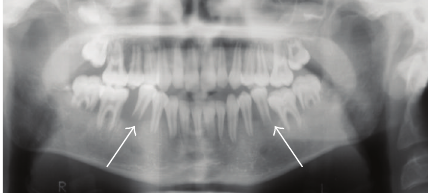
Figure 1: Panorex demonstrating resorption of alveolar bone of the lower first molars bilaterally with superior displacement of the teeth giving a “floating teeth” appearance.